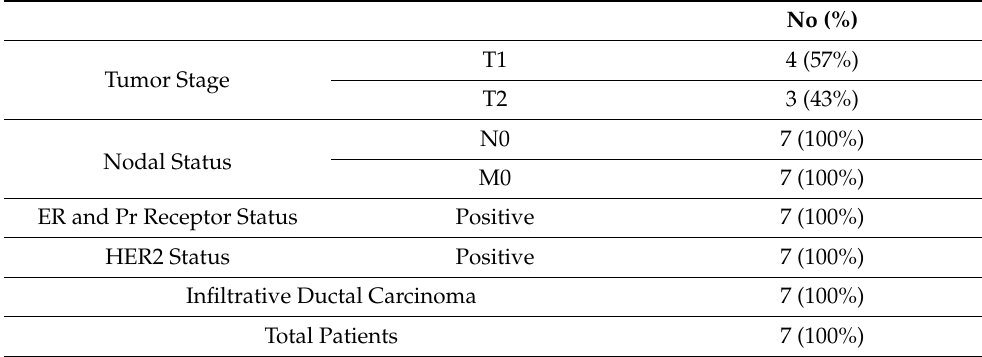
Table 1. General clinical characteristics of